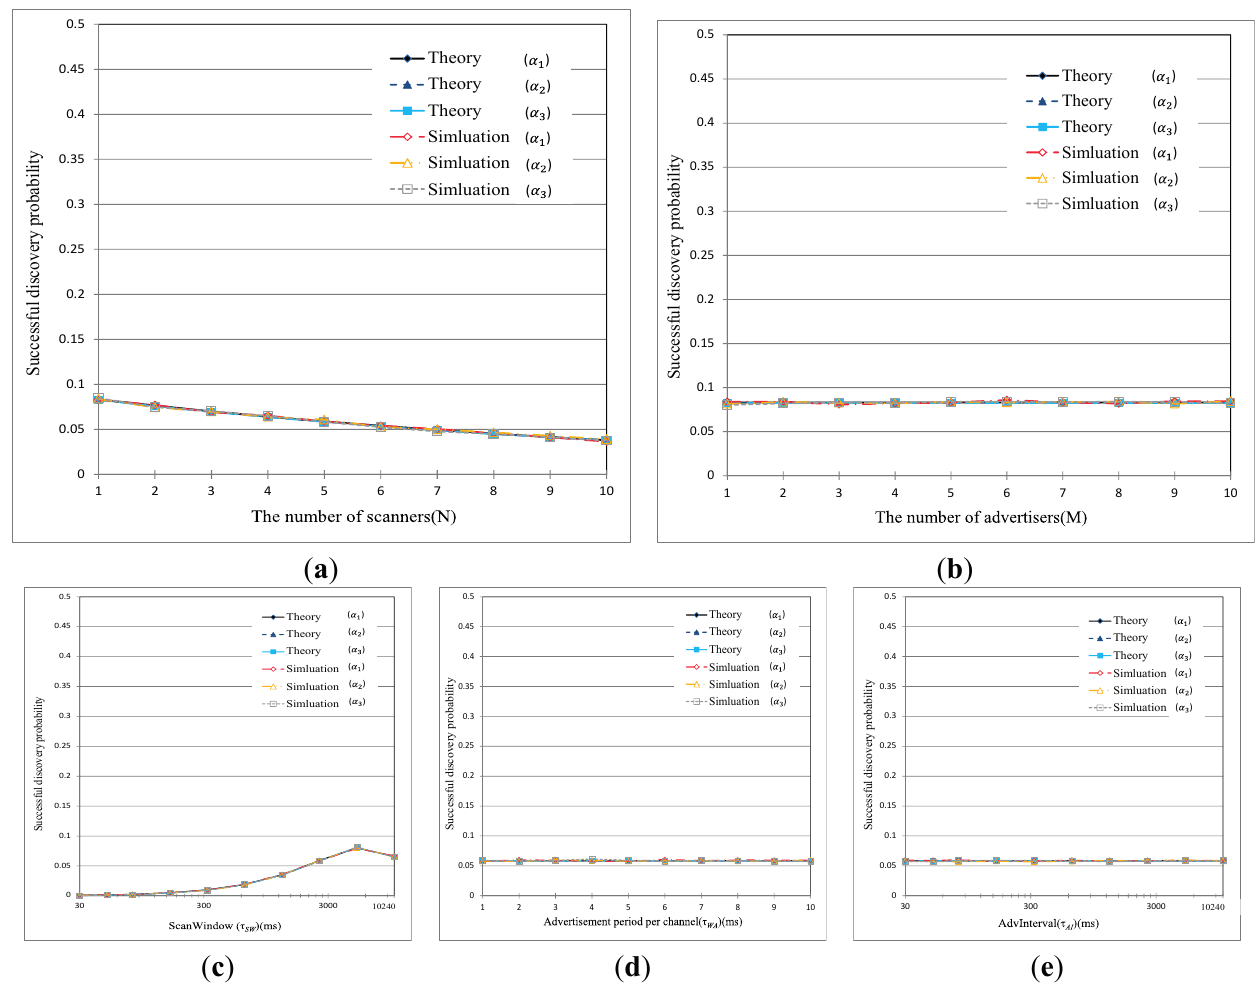
Figure 8. Probability of successful discovery on each advertising channel with various parameter settings. ( a ) The probability of successful discovery as the number of scanners increase ( τ SI = 10,240, τ SW = 2560, τ WA = 10, τ AI = 1280, M = 5); ( b ) the probability of successful discovery as the number of advertisers increase ( τ SI = 10240, τ SW = 2560, τ WA = 10, τ AI = 1280, N = 5); ( c ) the probability of the successful discovery as the ScanWindow ( τ SW ) is varied is ( τ SI = 10,240, τ WA = 10, τ AI = 1280, M = 5, N = 5); ( d ) the probability of the successful discovery as τ WA is varied ( τ SI = 10,240, τ SW = 2560, τ AI = 1280, M = 5, N = 5); ( e ) the probability of the successful discovery as AdvInterval ( τ AI ) is varied ( τ SI = 10,240, τ SW = 2560, τ WA = 10, M = 5, N =